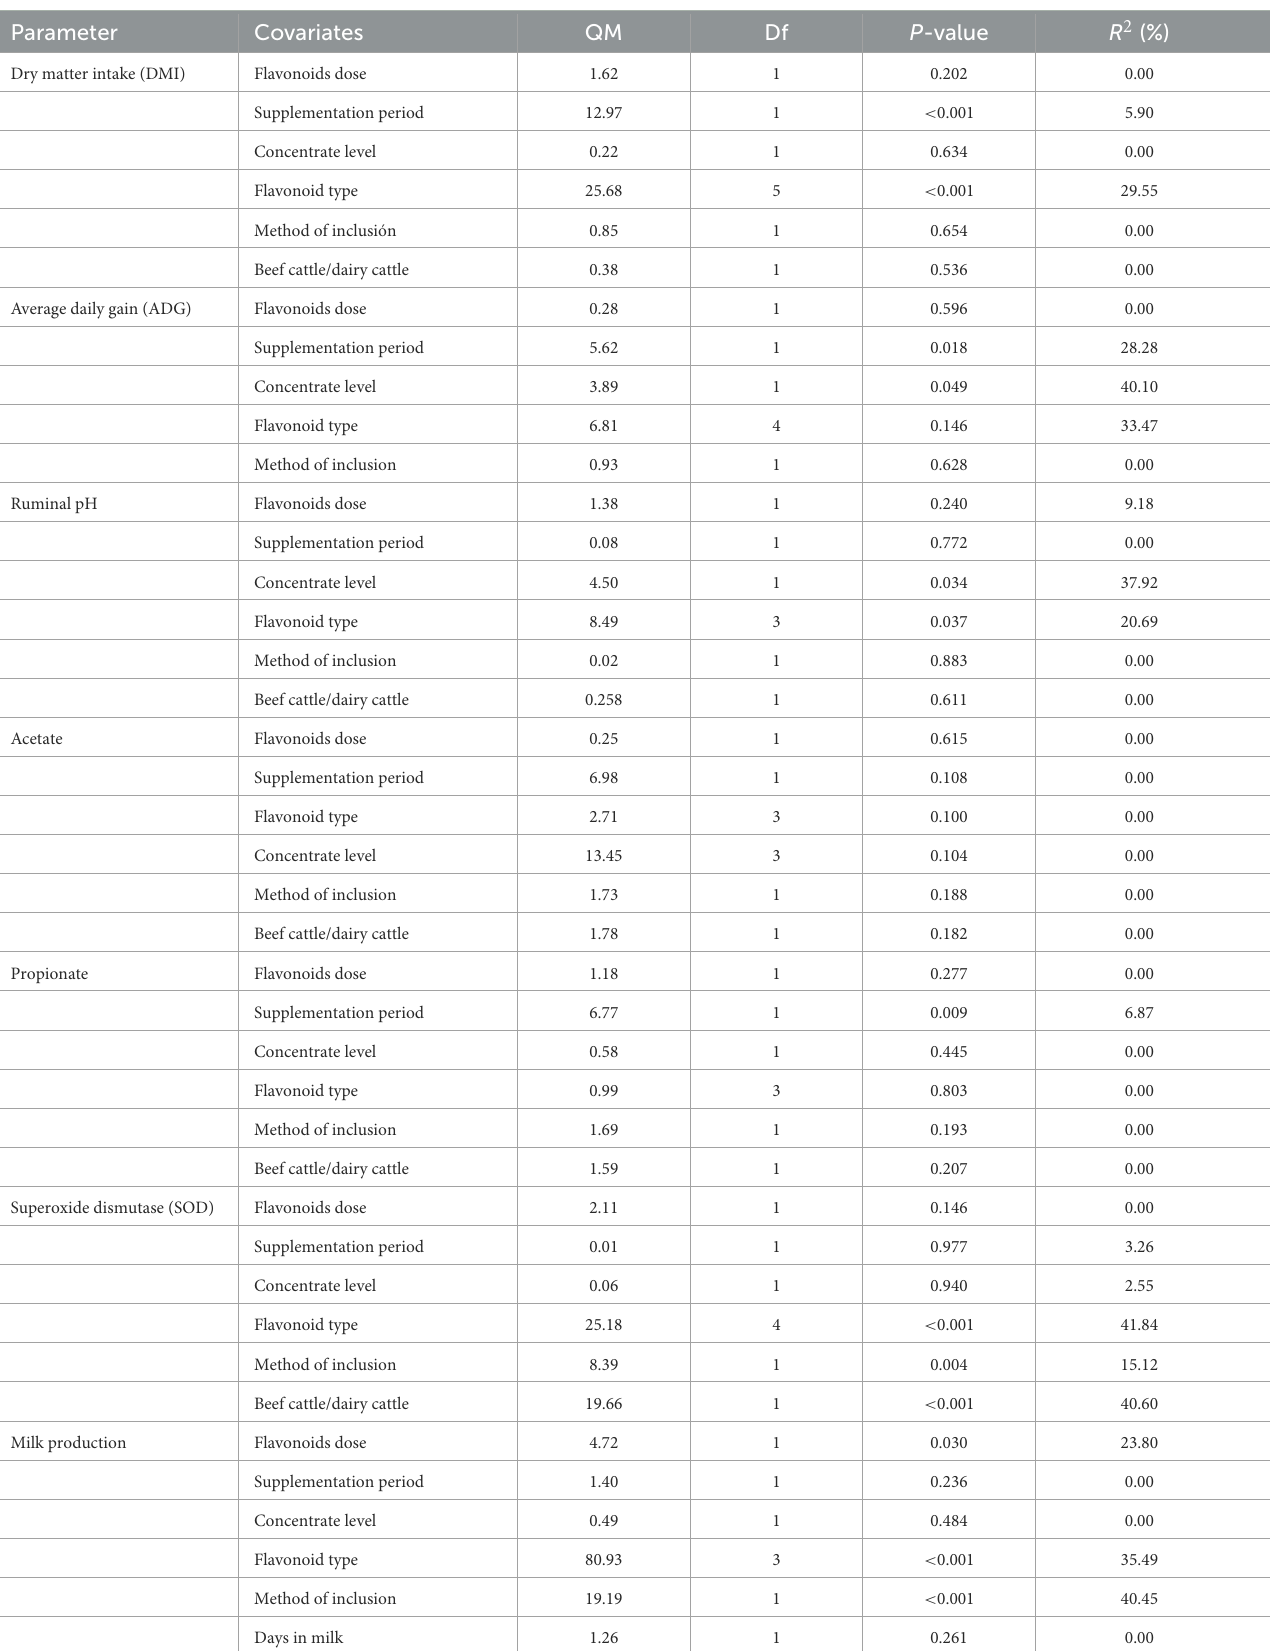
TABLE 7 Meta-regression comparing the associations between covariates and measured outcomes.